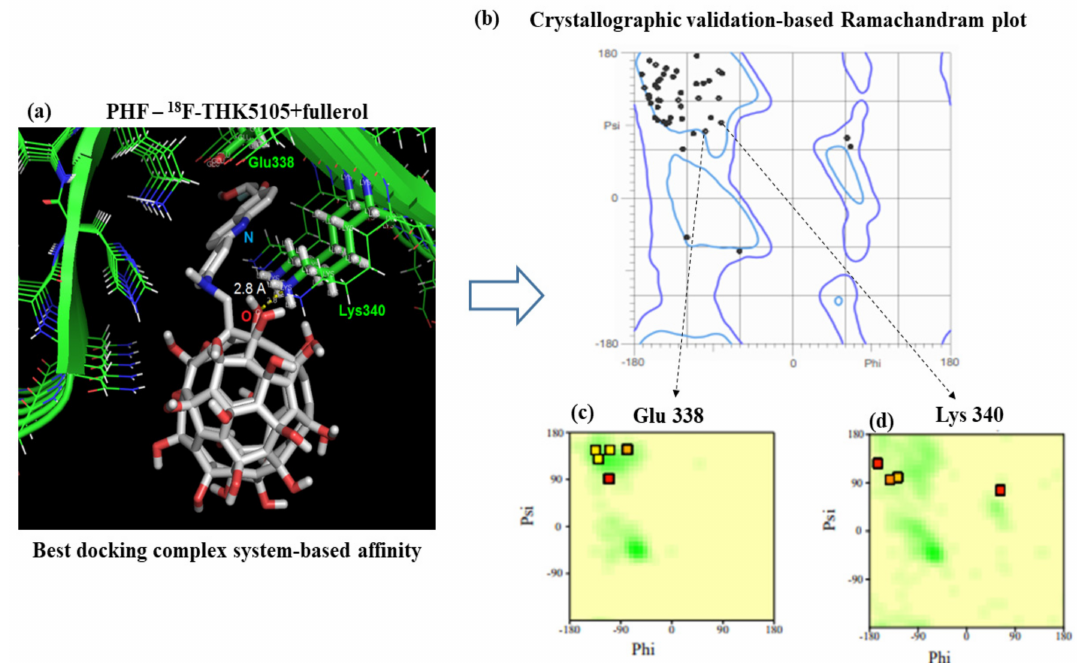
Figure 4. ( a ) Representation of the three-dimensional tau protein (PDB ID: 5O3L) binding site target residues (Glu338 and Lys340) interacting with atoms from the PHF- 18 F-THK5105 + fullerol for the docking system “e” (as previously denoted by the code letter). ( b ) Representation of Ramachandran diagrams obtained for all the residues composing the tau protein. The two arrows ( c , d ) are depicted to show the individual Ramachandran diagram of the interacting target residues (Glu338 and Lys 340). All the possible combinations of torsion dihedral angles Phi ( ϕ ) vs. Psi ( Φ ) are shown. Note the total absence of Ramachandran outlier residues for the three conditions evaluated (general and individual Ramachandran plot), usually unfavored residues or torsion angles (Phi ( ϕ ) vs. Psi ( Φ )) are located outside the Ramachandran colored-purple contour or green zone in the case of individual Ramachandran plots, if